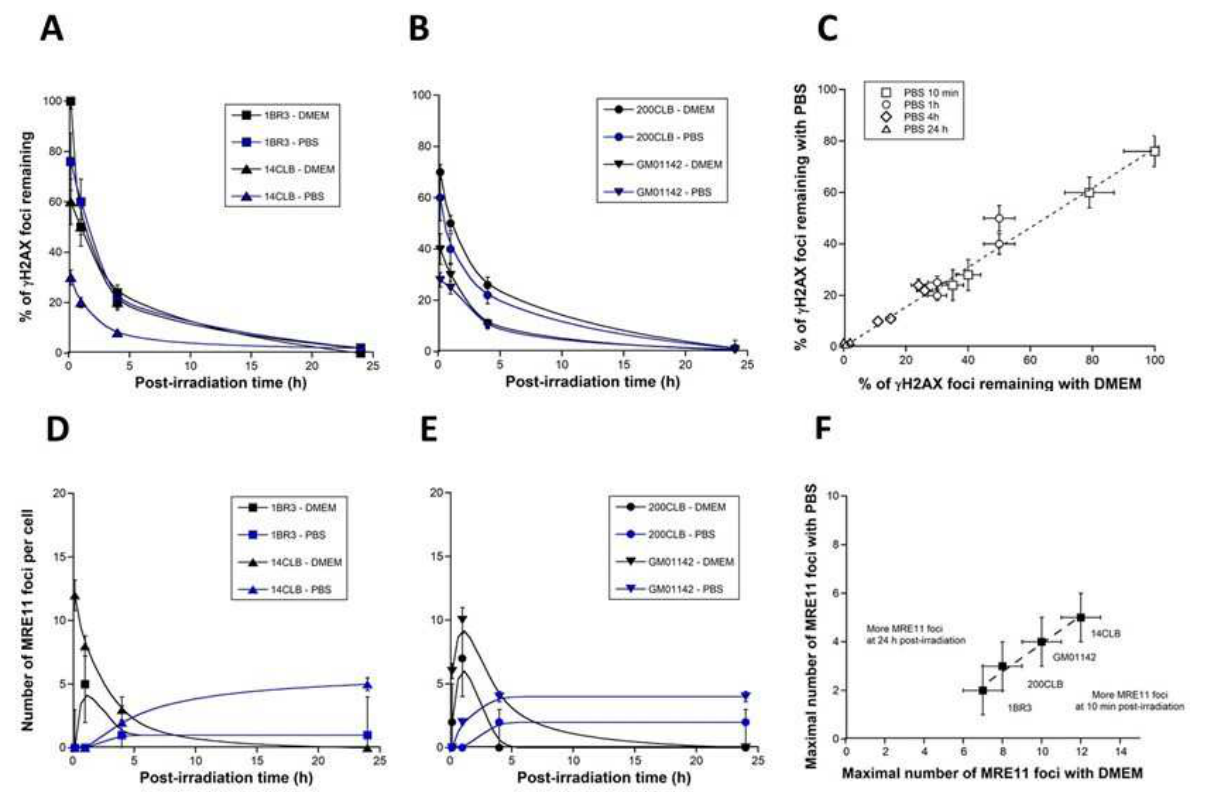
Figure 9. Calcium, RIBE and radiosensitivity. Th indicated four fibroblast cell lines with different radiosensitivity status were irradiated (2 Gy) with 6 MeV photons in presence of the indicated media (DMEM or PBS) and subjected to anti- γ H2AX ( A , B ) or - MRE11 ( D , E ) immunofluorescence at the indicated post-irradiation times. Each data plot represents the mean ± SEM of at least three replicates. Data were fitted to the Bodgi’s formula [47]. ( C ) The γ H2AX data obtained with DMEM and PBS shown in panels ( A , B ) were plotted together with their corresponding error bars (SEM). The dotted line corresponds to the following formula: y = 0.75x (r = 0.99). ( F ) The MRE11 data obtained with DMEM and PBS shown in panels ( D , E ) from the indicated four fibroblast cell lines were plotted together with their corresponding error bars (SEM). The dotted line corresponds to the following formula: y = −1.83 + 0.576 × (r = 0.989).